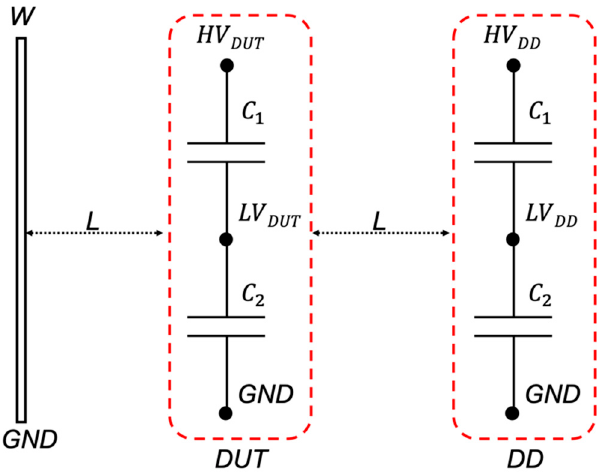
Figure 2. The measurement setup defined in Standard IEC 61869-11 [8].